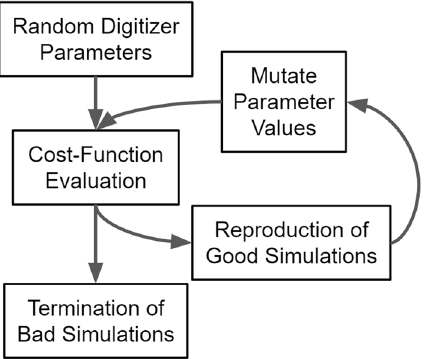
Figure 5. The flow diagram for ACCES is applied to optimising free parameters in a digitizer of a GATE detector